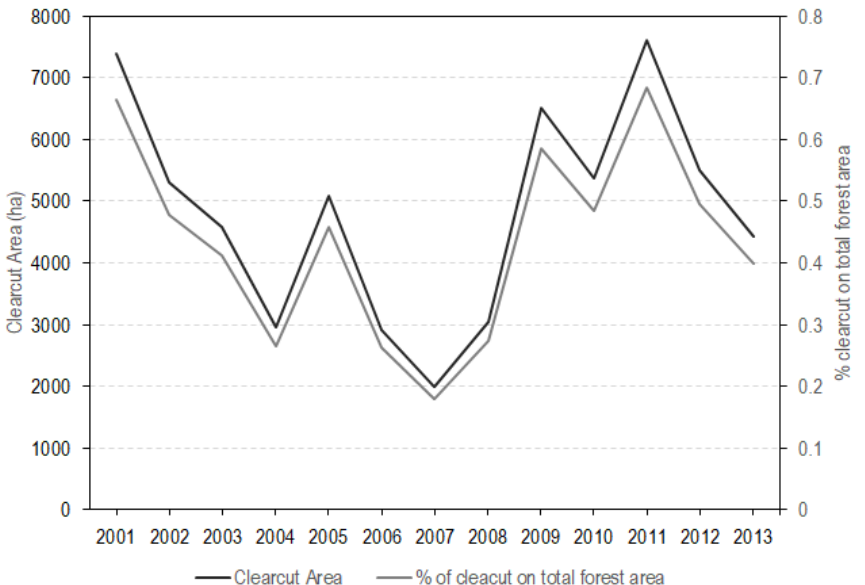
Figure 7. Yearly clearcut area (line black—first vertical axis) and percentages of forest area logged (grey line—second vertical axis) in the portion of Landsat scene 192 030 within the borders of Tuscany Region.